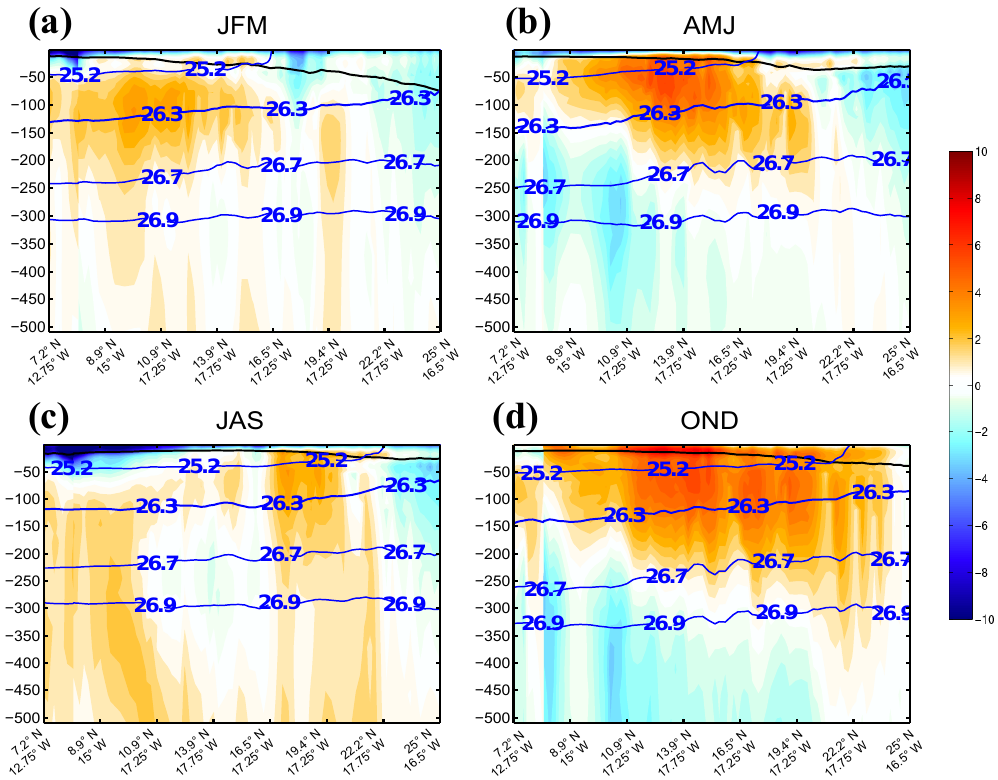
Figure 9. Seasonally averaged vertical section of along-slope velocity (in colors; cms − 1 ), σ t (blue lines; kgm − 3 ), and mixed layer depth (black line; in meters) following the shelf break (across-shore averaging between the 100m isobath and six grid points 150km